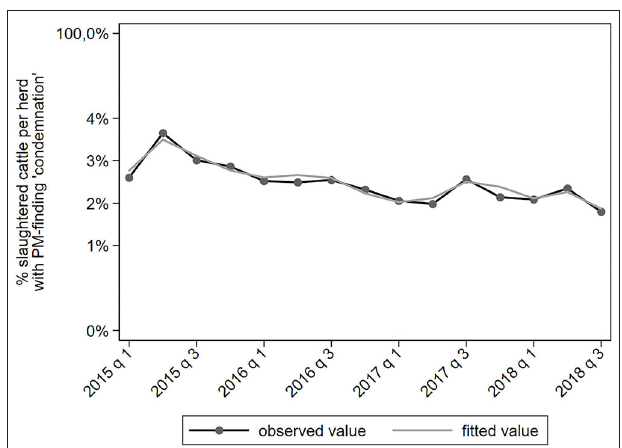
FIGURE 4 | Observed and predicted percentage of slaughtered cattle per dairy herd with a PM-finding categorized under “condemnation,” per quarter between January 2015 to September 2018 ( N = 78,366).